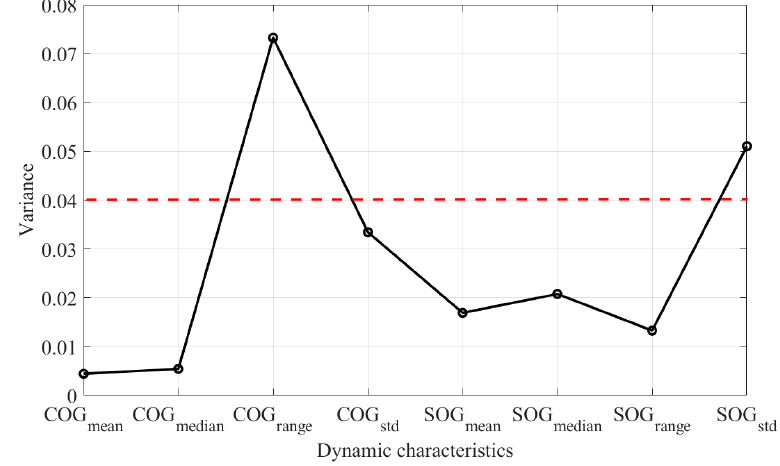
Figure 12. Distribution of motion parameter variance.